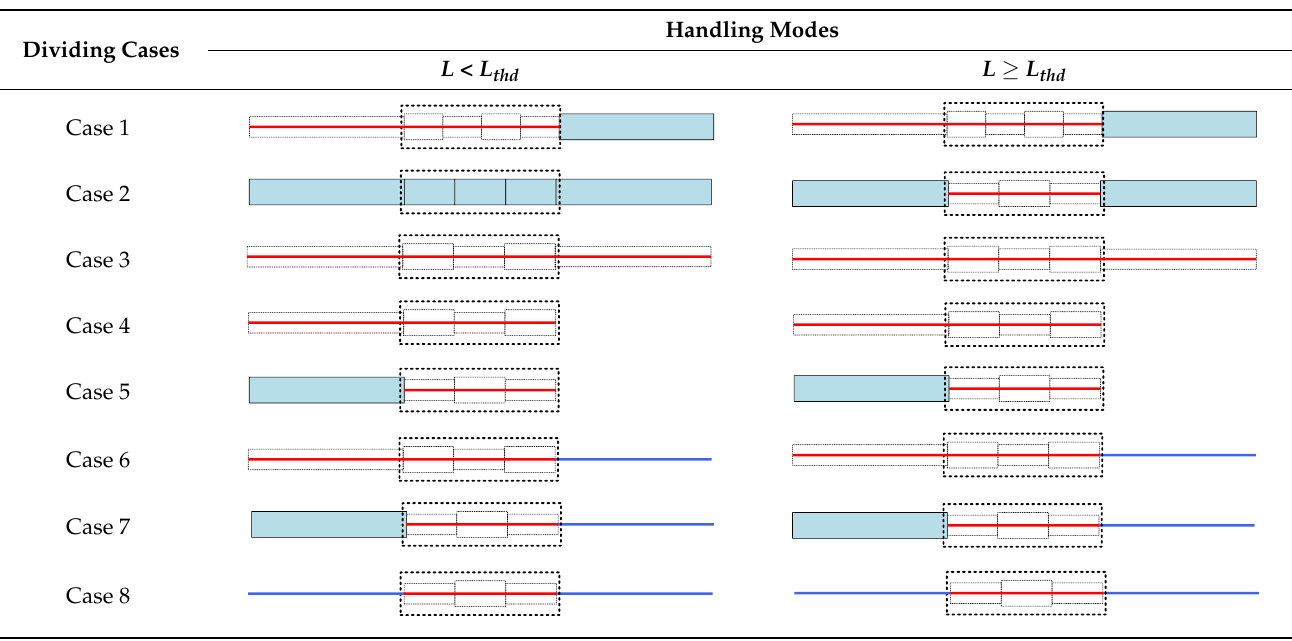
Table 2. Cases of collapse priority strategy.